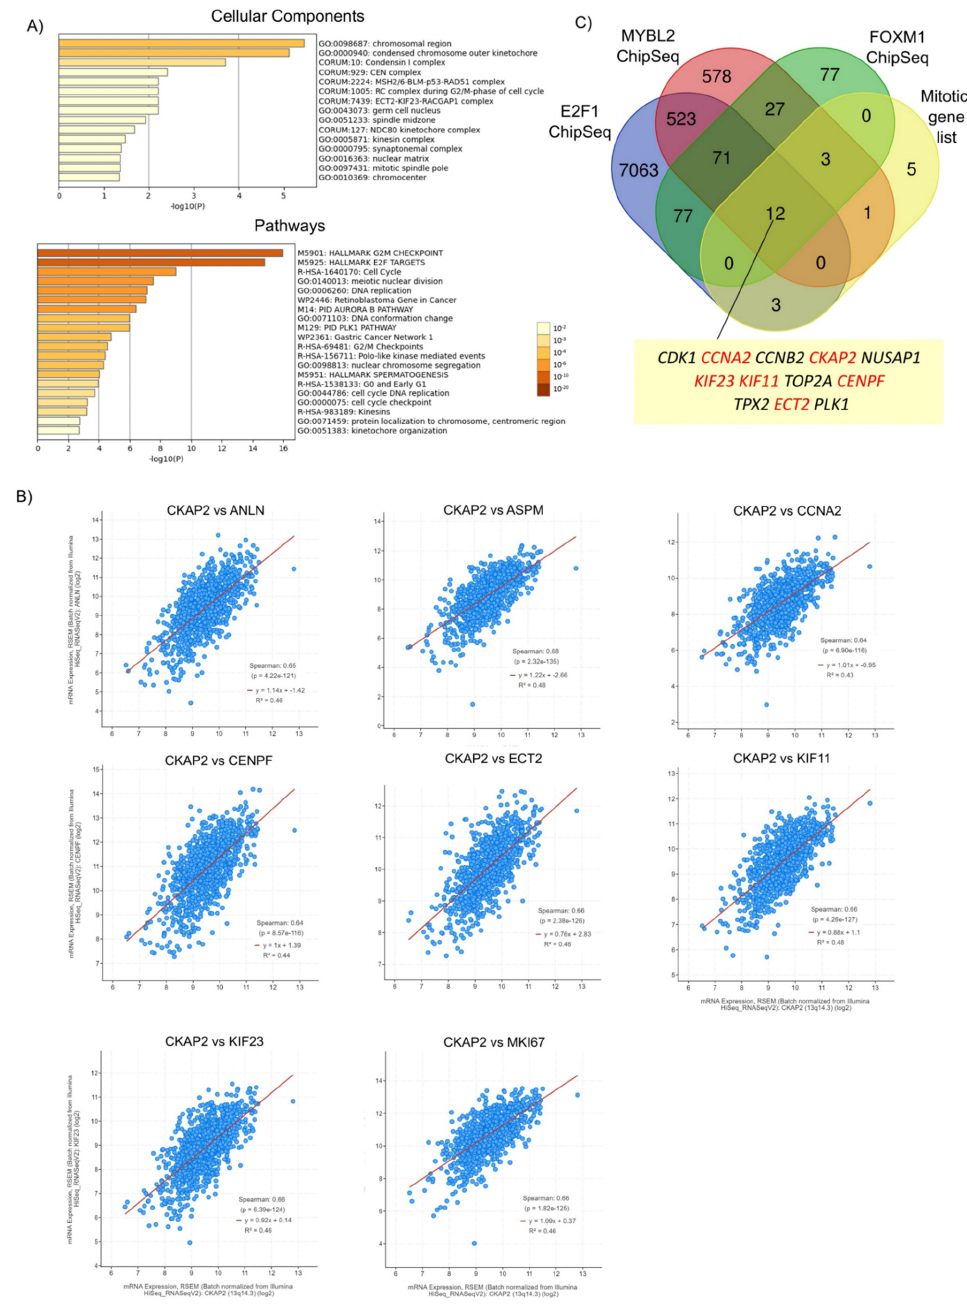
Figure 5. Highly correlated genes (Spearman’s correlation r ≥ 0.5) co-expressed with CKAP2 in TCGA-BRCA cohort. ( A ) Bar graph of enriched terms across input gene list, colored by p -values, using Metascape. Upper graph: cellular components. Lower graph: pathways. ( B ) Correlation between CKAP2 and 8 selected genes from the top 30 highly correlated genes (r ≥ 0.5), which are also present in the list of 24 mitotically relevant genes. ( C ) Venn diagram showing the overlap of ChIP-seq datasets for E2F1 , MYB2L , and FOXM1 with the list of 24 mitotic genes. This analysis showed that all transcription factors collectively bind to the promoters of 12 mitotic genes (including CKAP2 ). Eleven genes were highly co-expressed with CKAP2 and upregulated in IDC (highlighted in red). Data with p < 0.05 were considered statistically significant. p -value ( p